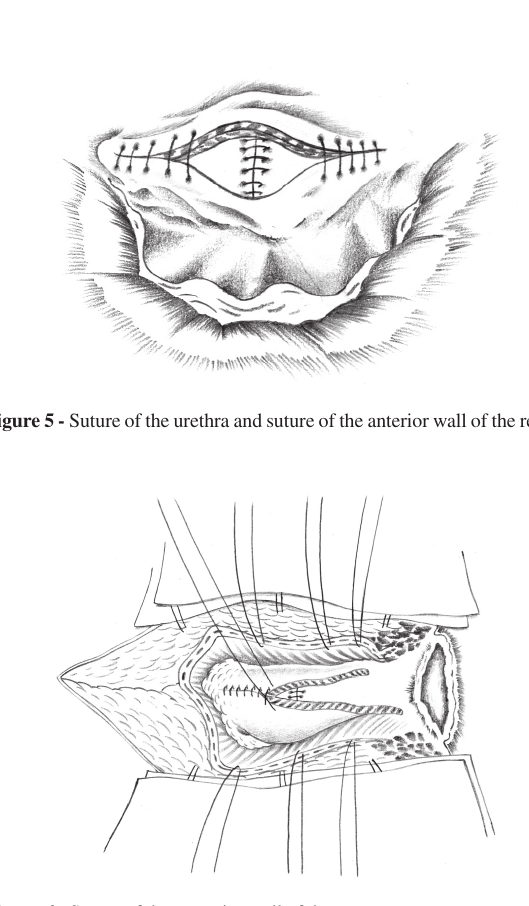
Figure 6 - Suture of the posterior wall of the rectum.